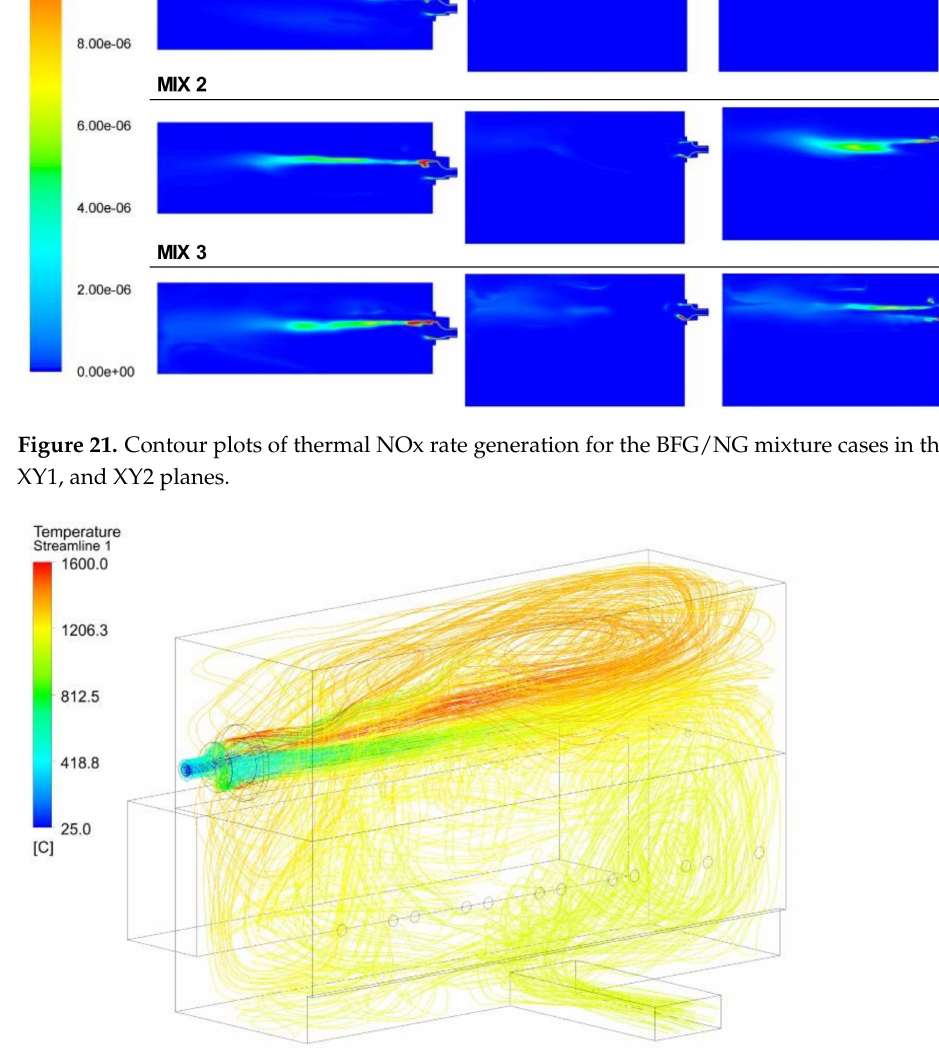
Figure 22. Temperature streamlines for the MIX 1